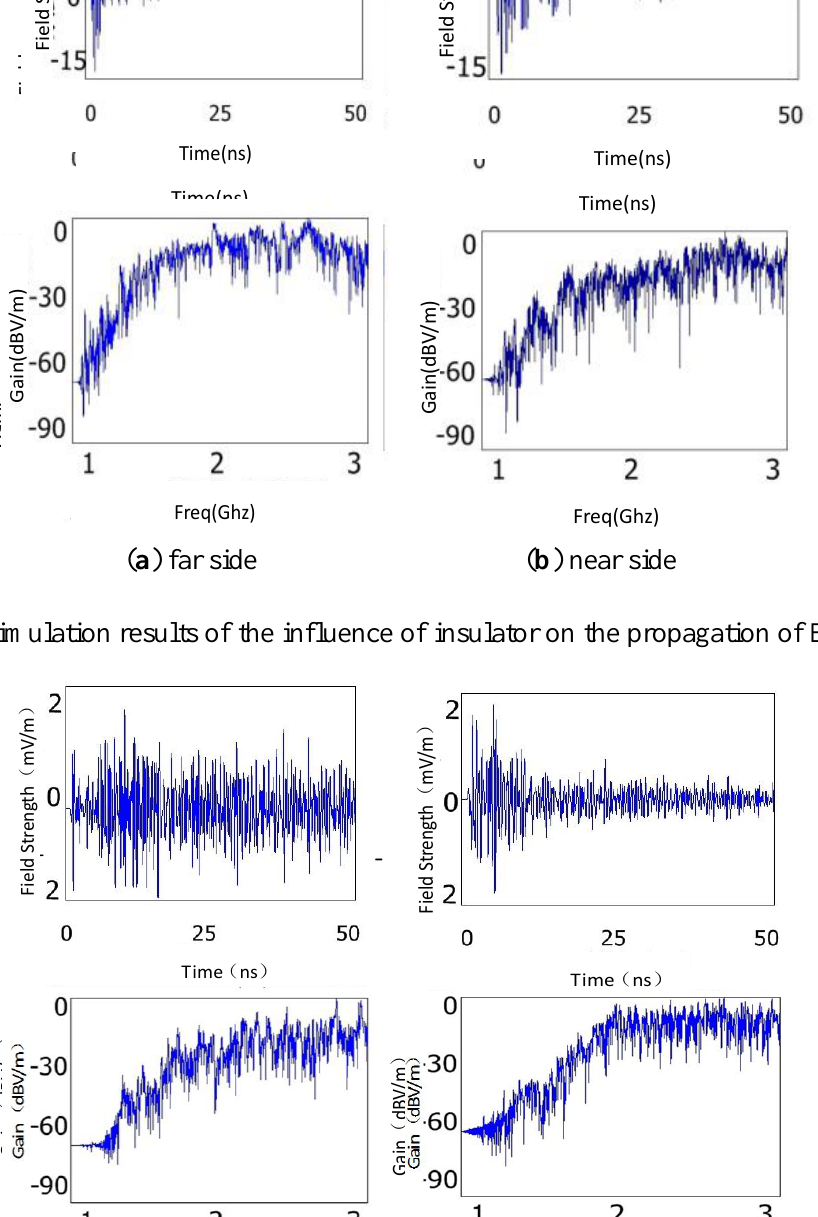
( a ) far side ( b ) near